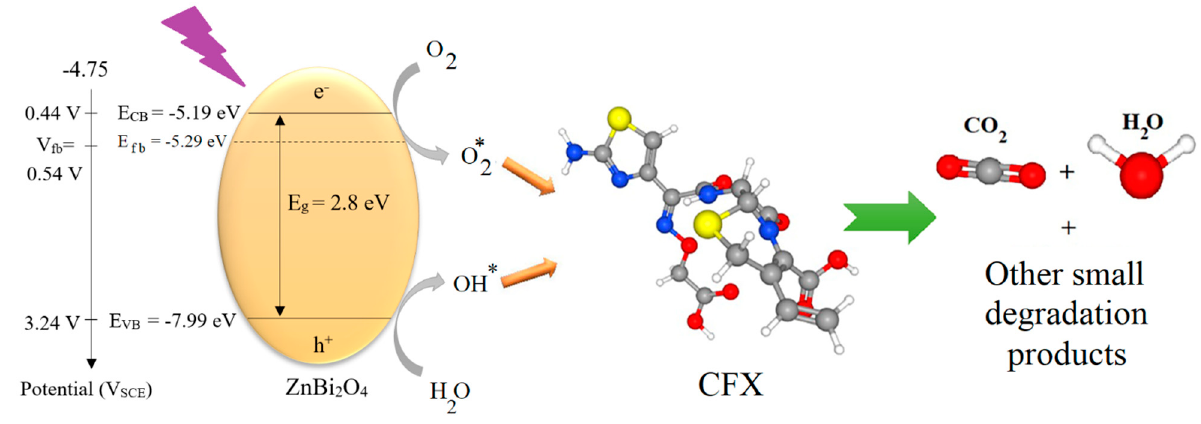
Figure 10. Energy diagram and suggested mechanism for CFX degradation by ZBO nanoparticles.